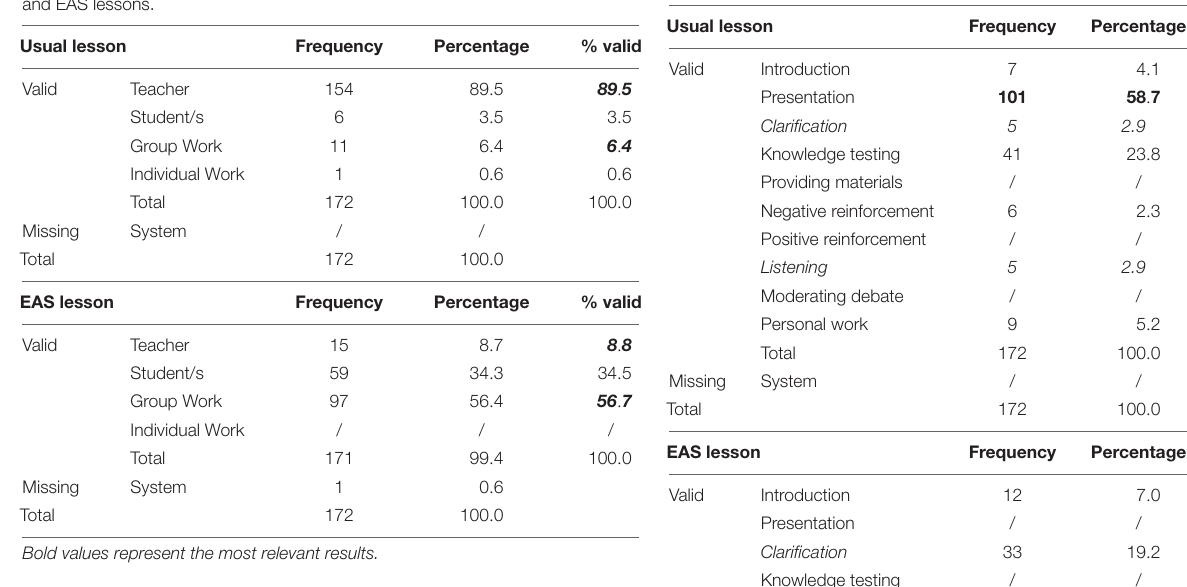
TABLE 5 | Difference in teacher actions between usual lessons and EAS lessons.